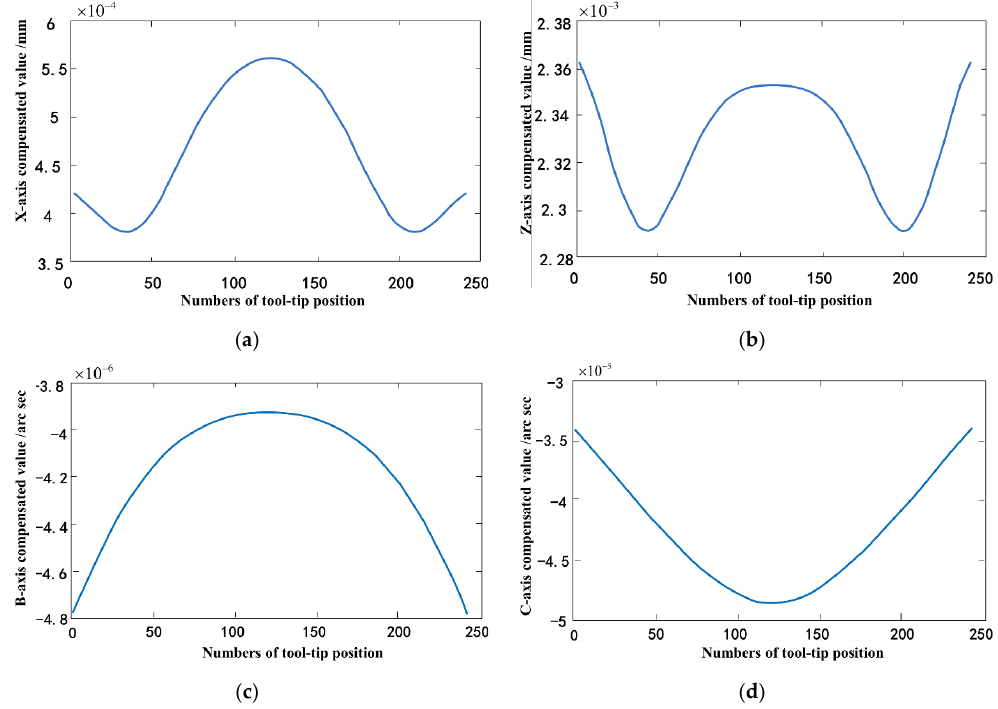
Figure 14. Axis compensated value from geometric error. ( a ) X − axis compensated value. ( b ) Z − axis compensated value. ( c ) B − axis compensated value. ( d ) C − axis compensated value.